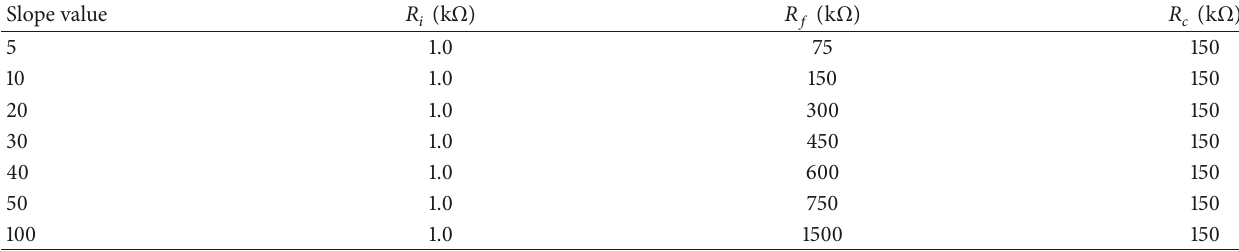
Table 2: Circuit element values for implementing different slopes using Figure 3.